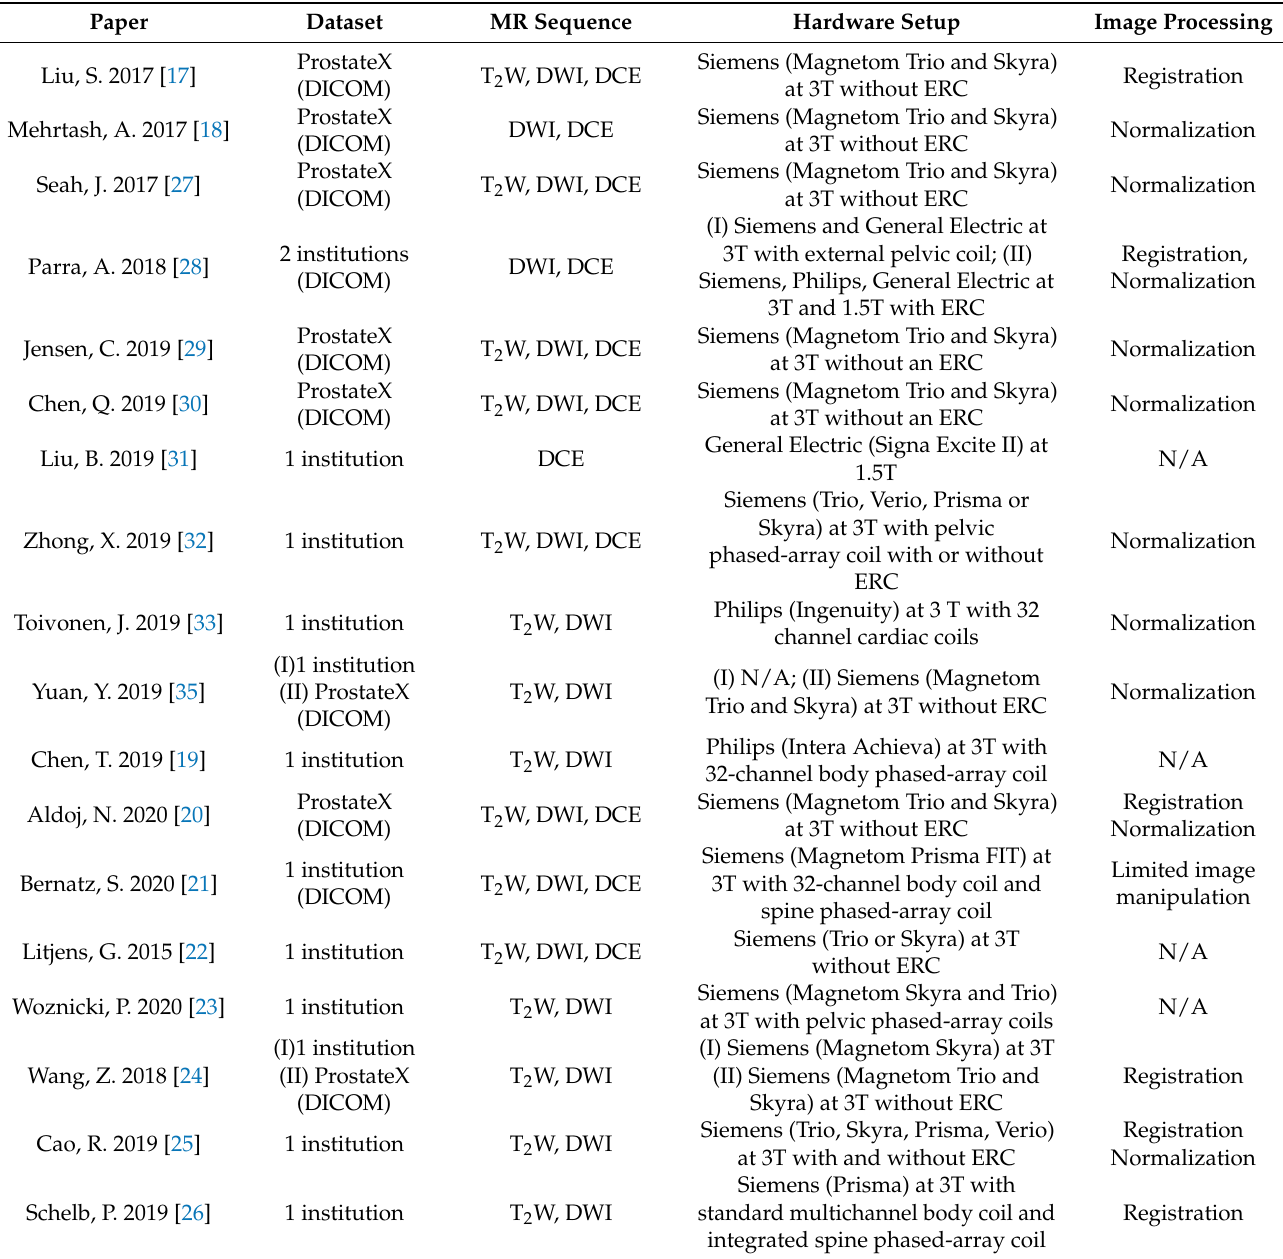
Table 1. Table reporting general information on datasets (and their format), MR sequences, scanners, coils, and the image preprocessing (normalization or registration)